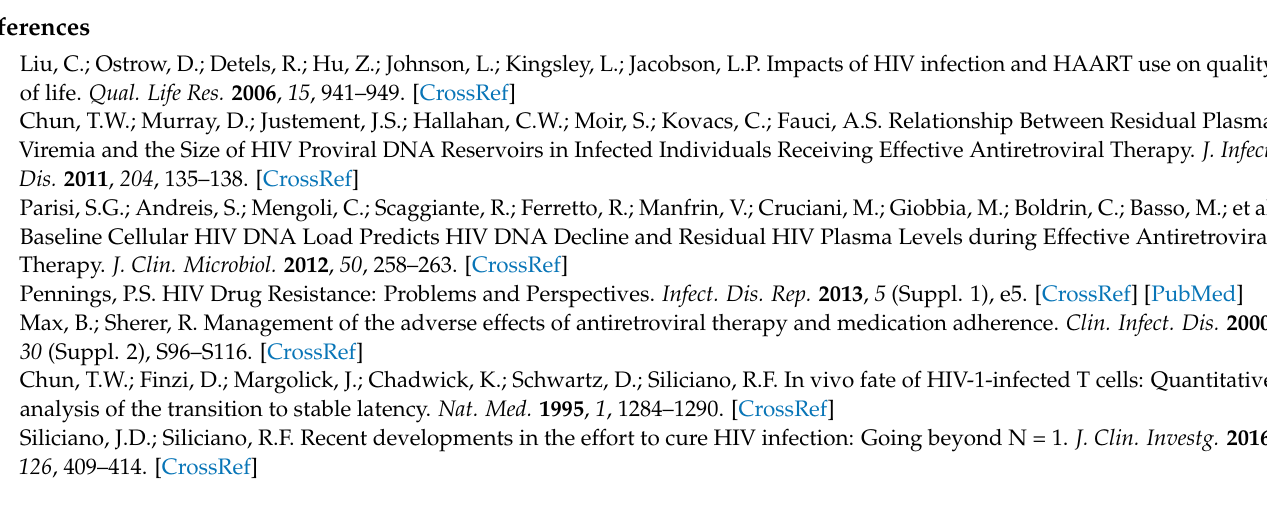
HIV-1 encoding fluorescent tag, Figure S3: Measurement of viral replication by flow cytometry, Figure S4: Catalytically inactive CasRx (dCasRx) with HIV-specific guide RNAs do not affect HIV replication, Figure S5: Plasmid Design – pKLV2-U6-CasRx-(pre-gRNA)-PGKpuro2ABFP-W, Table S1: Oligonucleotide primers, Table S2: guide RNA design, Table S3: variation in gRNA seed